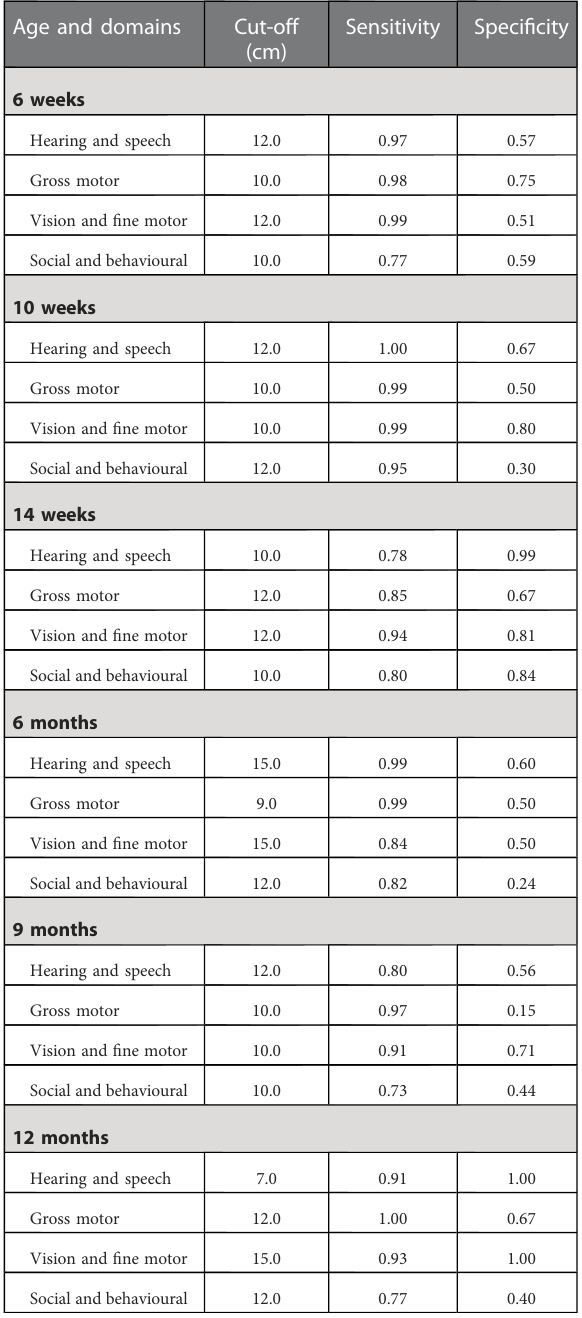
TABLE 3 Cut-off values for sum ISDS scores for the four domains of development. Age and